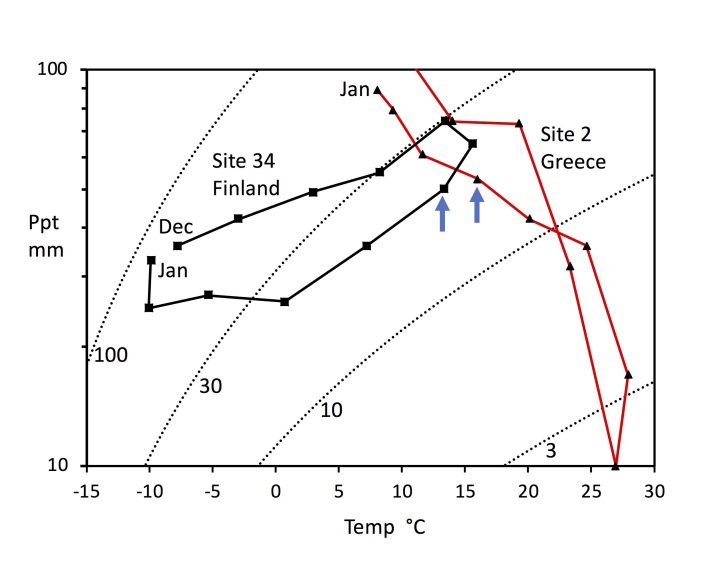
Comparison of the climates at the northernmost and southernmost localities for Bactericera
albiventris. Hythergraph showing mean monthly temperature and precipitation (see methods for details). The climate track for the Finnish site shows the winter-dry, summer-wet climate, whereas the climate track for the Greek site shows the winter-wet, summer-dry climate characteristic of the Mediterranean. Collection months are arrowed.